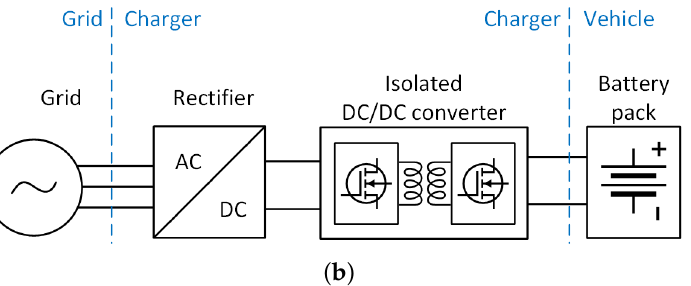
Figure 2. Off-board chargers. ( a ) Off-board charger with a low-frequency isolation transformer. ( b ) Off-board charger with a high-frequency isolation